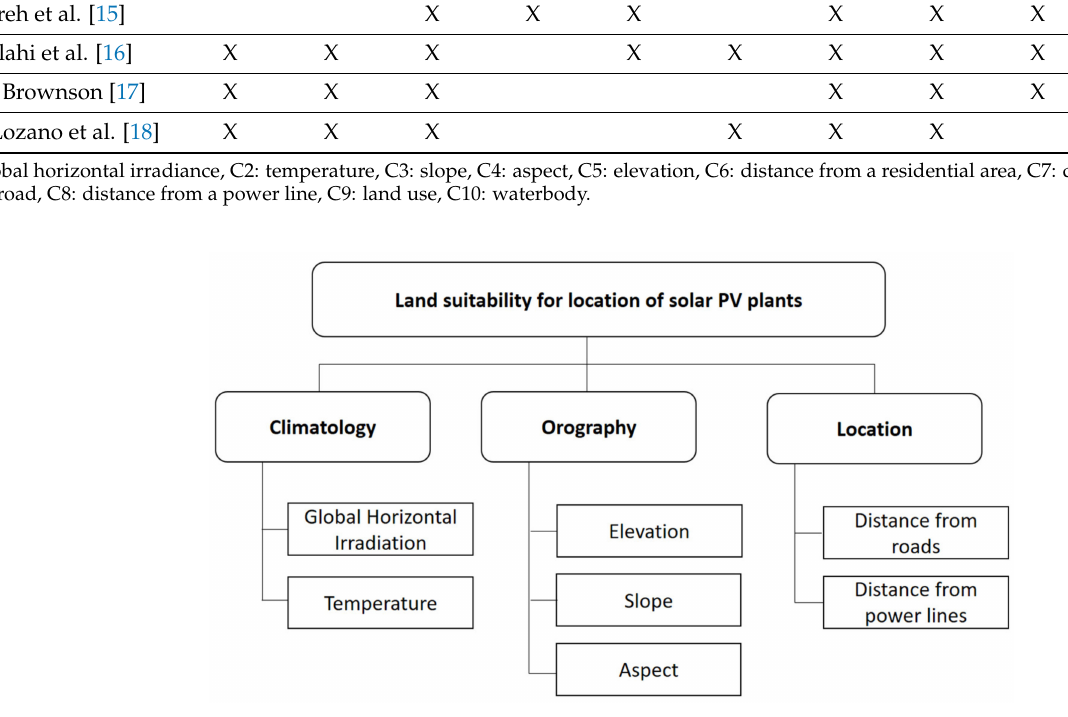
Figure 2. Selection criteria used in PV site suitability analysis in Mongolia.